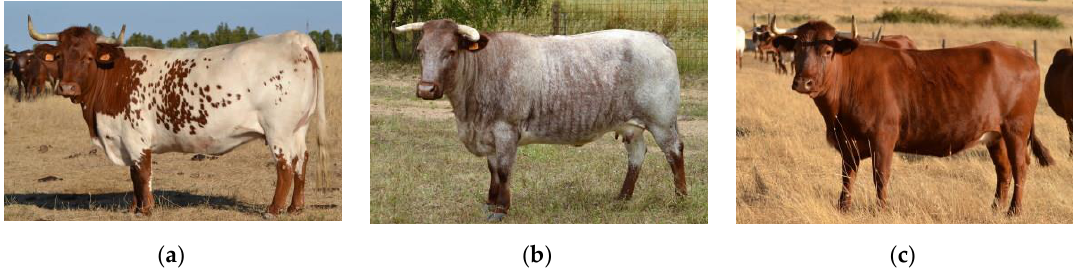
Figure 1. Different Mertolenga coat types: ( a ) red spotted, ( b ) roan, ( c ) red. Figure 1. Di ff erent Mertolenga coat types: ( a ) red spotted, ( b ) roan, ( c )